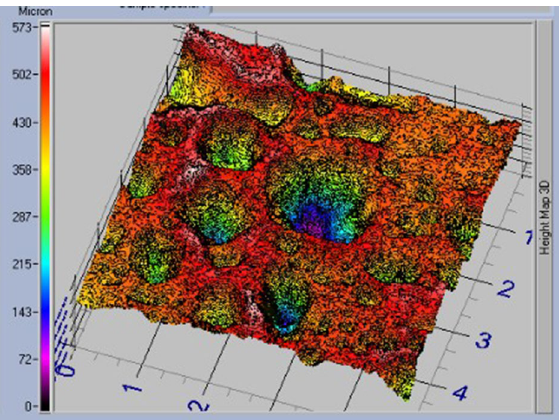
Figure 12. Roughness data from TRACEIT optical surface roughness